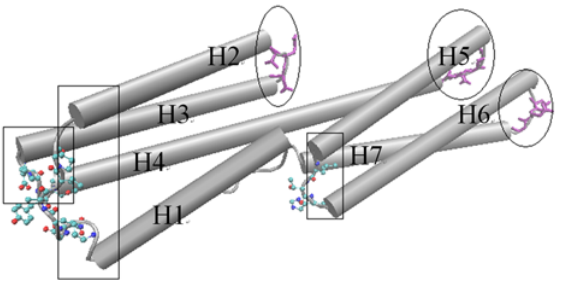
Figure 3. The cartoon diagram for the rotational motion mode of the D1 domain. The regions with low fluctuation are drawn using licorice method, and marked with ovals. The regions with high fluctuation are drawn using CPK method and marked with